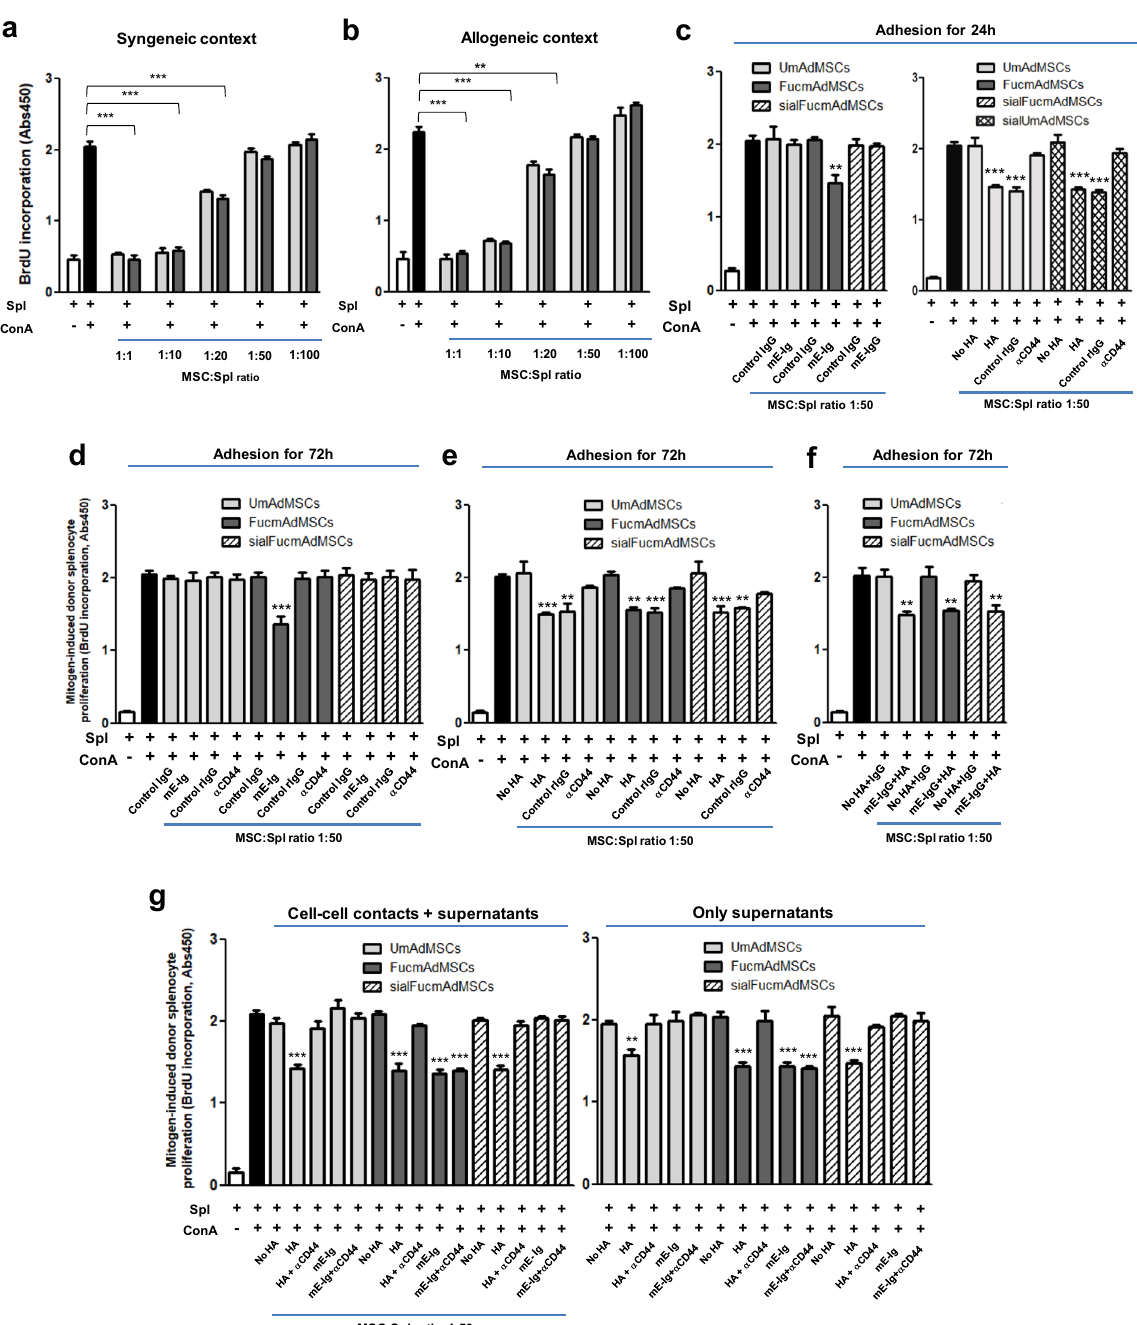
Fig. 5 Effects of HCELL/CD44 engagement on immunomodulatory properties of mAdMSCs. a Splenocytes (Spl) from C57BL/6 (syngeneic context) or b from BALB/C mice (allogeneic context) were stimulated with concanavalin A (ConA) in the presence of different ratios of unmodi fi ed (UmAdMSCs) or FTVII-modi fi ed AdMSCs (FucmAdMSCs) from C57BL/6 mice. Mitogen-induced proliferation of responder splenocytes was measured by incorporation of BrdU. In presence of mAdMSCs, proliferation of responder splenocytes was signi fi cantly inhibited (** p < 0.01 or *** p < 0.001). c – f BALB/C splenocytes were stimulated with ConA in the presence of UmAdMSCs, FucmAdMSCs, or sialidase-treated UmAdMSCs (sialUmAdMSCs) all derived from C57BL/6 mice) at an MSC:splenocyte ratio of 1:50 (allogeneic context) that were previously cultured for c 24 h with E-selectin (mE-Ig) (left) or hyaluronic acid (HA) (right), or d previously cultured for 72 h with mE-Ig, e HA, or f both ligands, and then maintained in wells containing mE-Ig, HA, or both, respectively. As controls, E-selectin adherence of FucmAdMSCs was abrogated by sialidase treatment of the mAdMSCs (sialFucmAdMSCs), or by blocking adherence of mAdMSC to HA by culturing in presence of a blocking anti-CD44 antibody. Responder splenocyte proliferation was signi fi cantly inhibited (* p < 0.05, ** p < 0.01, or *** p < 0.001), respectively. g Inhibition of splenocyte proliferation in presence of conditioned media obtained from HA- or mE-Ig-ligated UmAdMSCs, FucmAdMSCs, or sialFucmAdMSCs (right) was analyzed compared to levels obtained in the continuous presence of the same type of mAdMSCs (left). As shown in panel at right, proliferation was signi fi cantly inhibited in presence of supernatant alone (*** p < 0.001). Data were analyzed by one-way ANOVA with Tukey ’ s multiple-comparisons